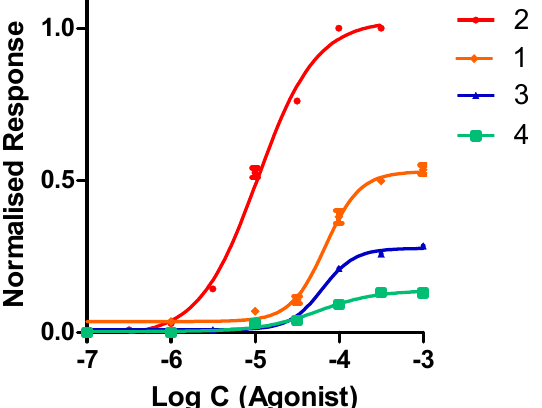
Figure 5. Interaction of phenylpyrrolidine derivatives with human α 4 β 2 nicotinic receptors expressed in Xenopus laevis oocytes. Whole cell currents in response to agonist application were measured by a two-electrode voltage clamp. Concentration-response curves show activation of whole cell currents by compounds 1, 2, 3, and 4. Each point represents data from four to five cells, normalized to the amplitude of the maximal responses of ACh, which was stimulated by 1 mM of ACh. The data are fitted to a single component Hill curve.